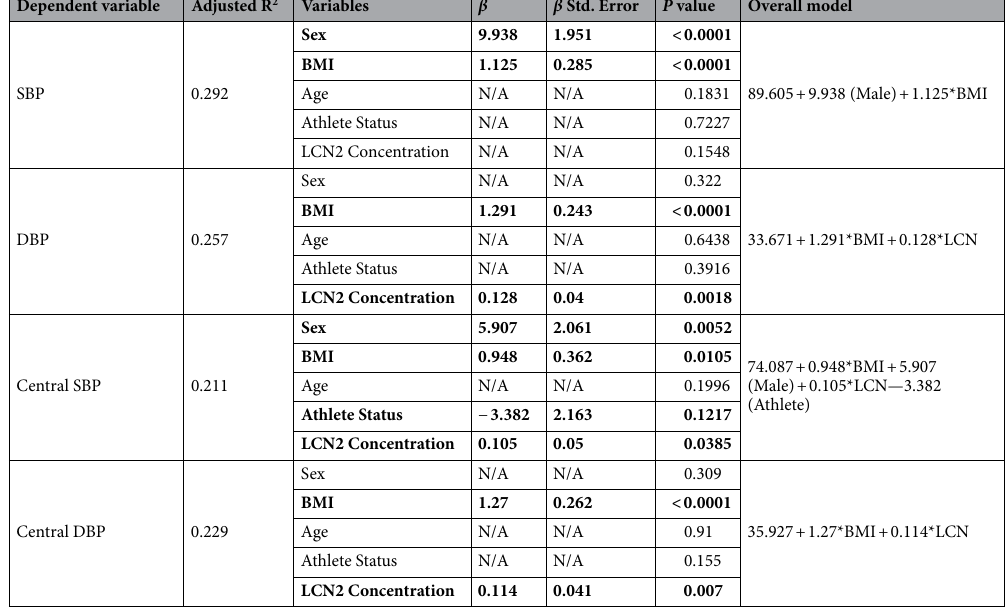
Dependent variable